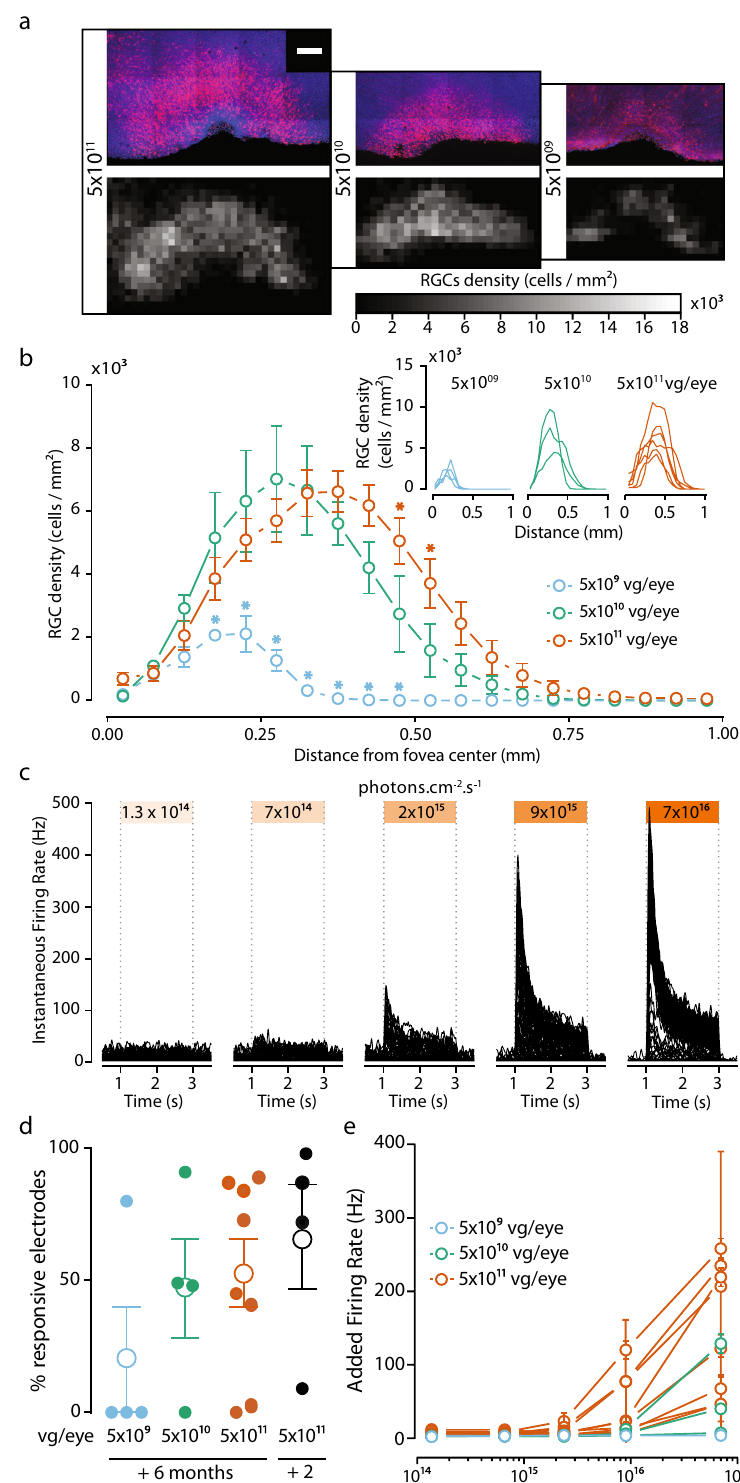
two-photon guided patch-clamp techniques, we obtained recordings for ChR-tdT-expressing RGCs in the perifoveal area with a cell-attached or voltage-clamp intracellular con fi guration (Fig. 4c). We fi rst replicated the analysis of photocurrent modulation by light intensity, comparing responses at 6 months (Fig. 4c – e) and 2 months of expression (see Fig. 1f – h). The